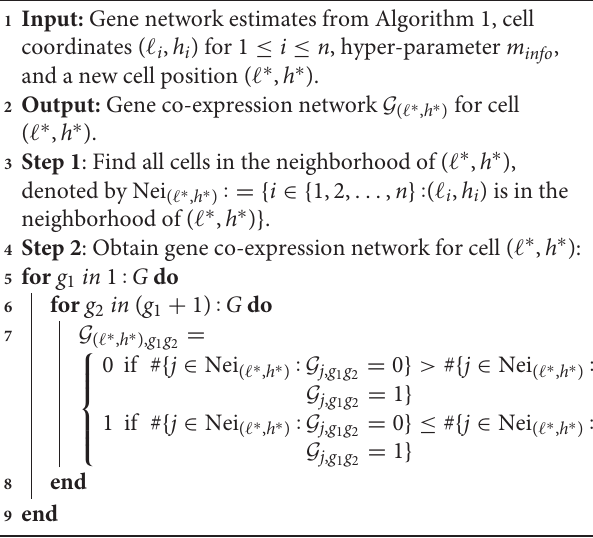
Algorithm 2: Gene co-expression network prediction for a new cell